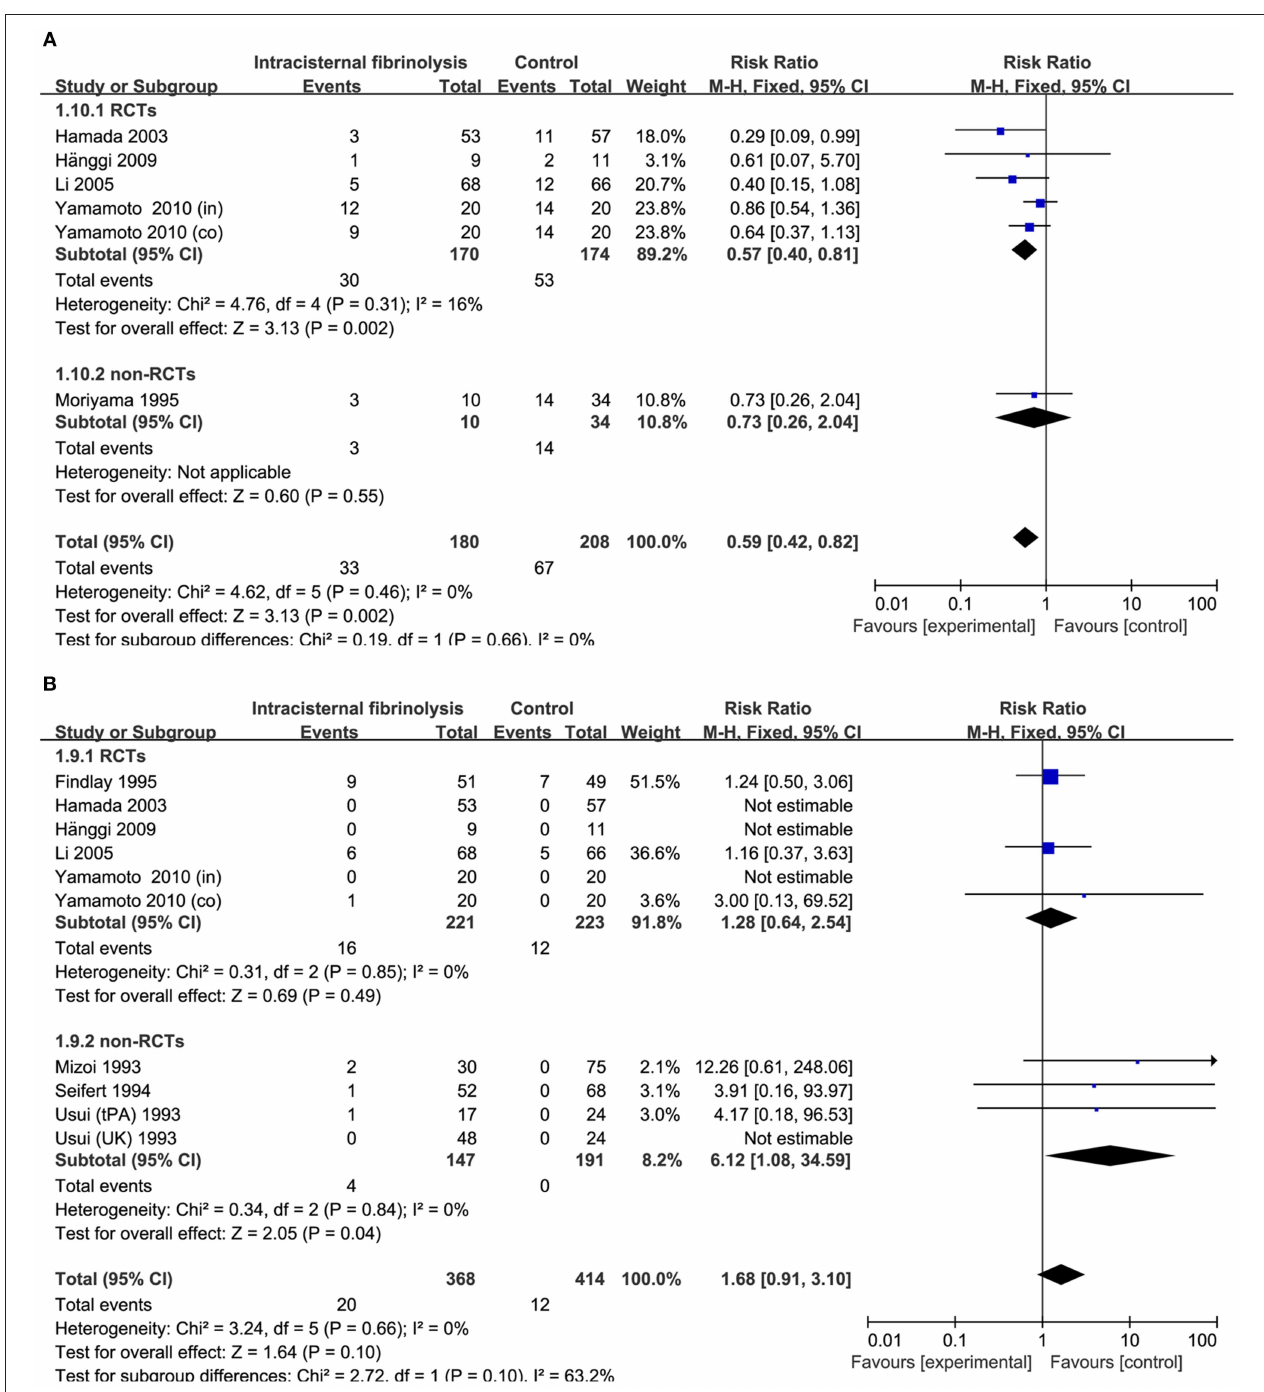
FIGURE 6 | Meta-analysis of associations between intracisternal fibrinolysis and the risk of chronic hydrocephalus (A) or the risk of hemorrhagic complications (B) in patients with aSAH. aSAH, aneurysmal subarachnoid hemorrhage; CI, confidence interval; M–H, Mantel–Haenszel method; RCTs, randomized controlled trials.